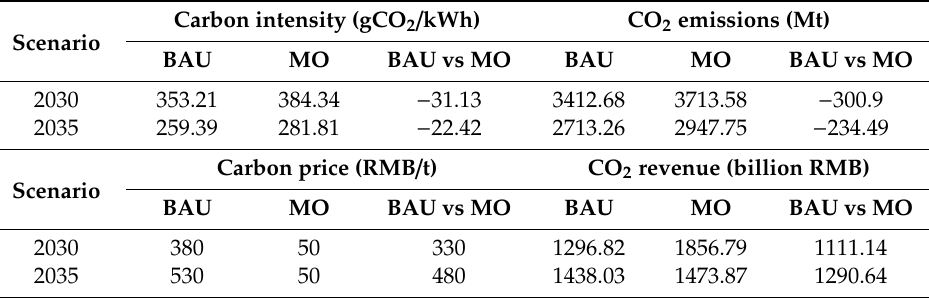
Table 16. Comparison of the CO 2 emissions and revenues between the MO and BAU carbon policy scenarios.